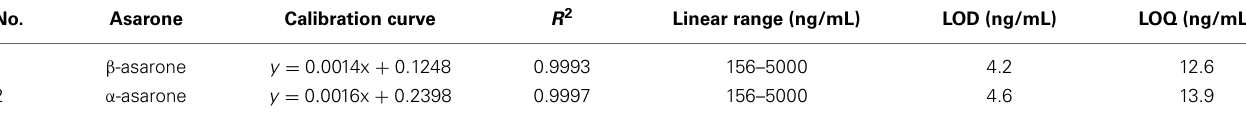
Table 1 | Linear regression data for the GC-MS method for quantification of asarones.